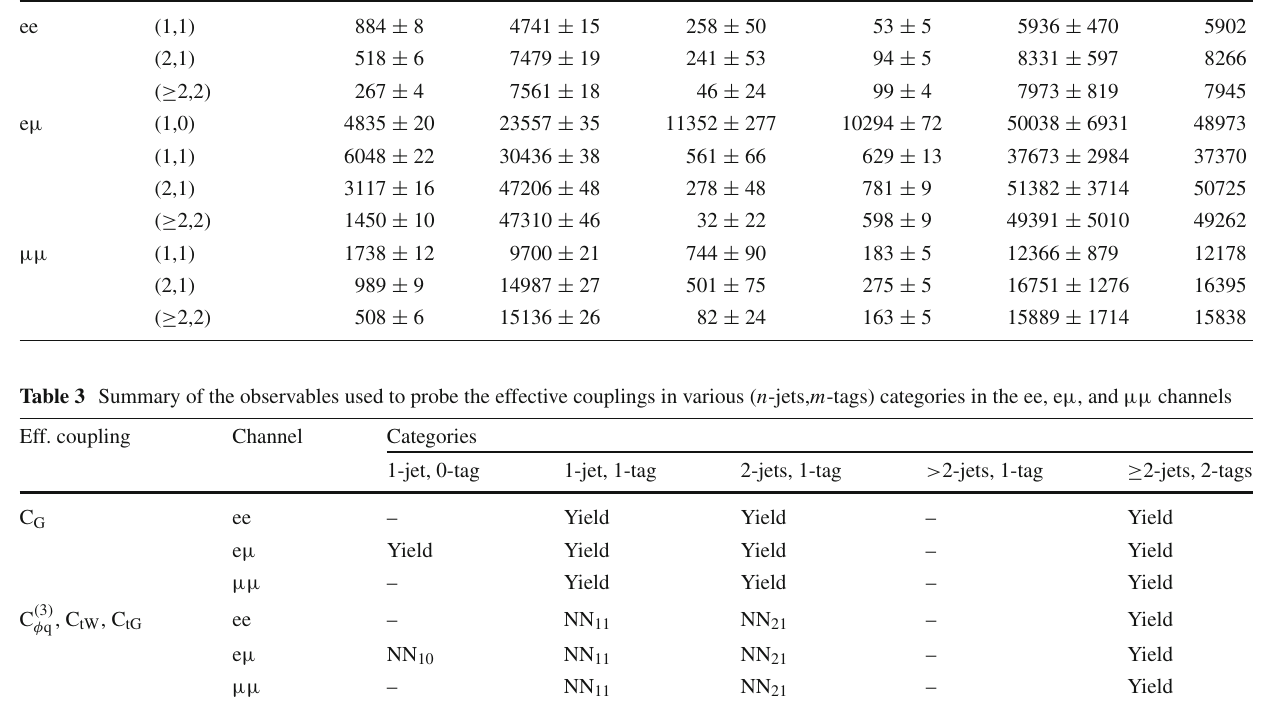
tainties correspond to the statistical contribution only for the individual background predictions and to the quadratic sum of the statistical and systematic contributions for the total background predictions